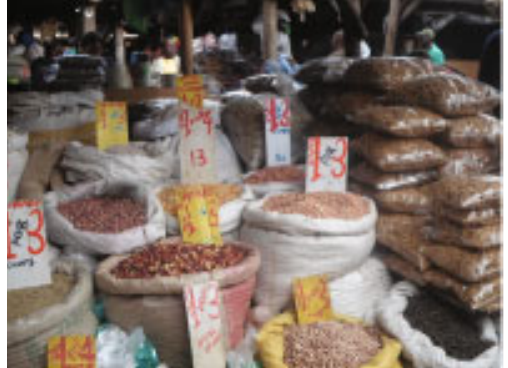
Figure 1: Agricultural produce on display at Mbare musika market including peanuts.